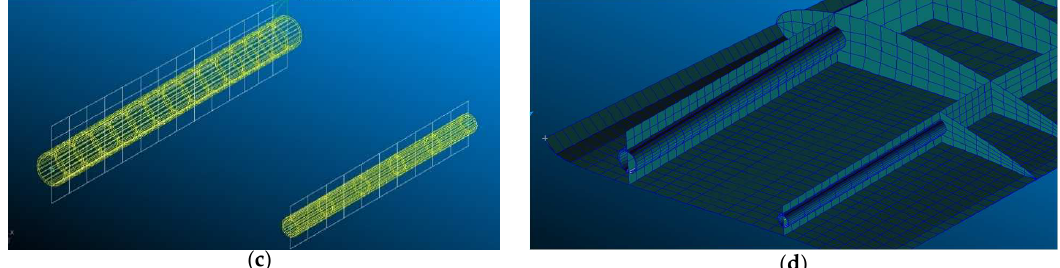
Figure 4. Finite elements Half-wing model. ( a ) Half wing FE model, ( b ) Half-wing FE model with associated properties: Balsa (green) for ribs and spars, Foam + CFRP (red) for the tubular spars, GFRP (blue) for the upper and lower panels, ( c ) Tubular spars discretization: BAR2 elements (yellow) for the CFRP spars and QUAD4 elements (white) for the connection with the skin, ( d ) 3D visualization of tubular spars.